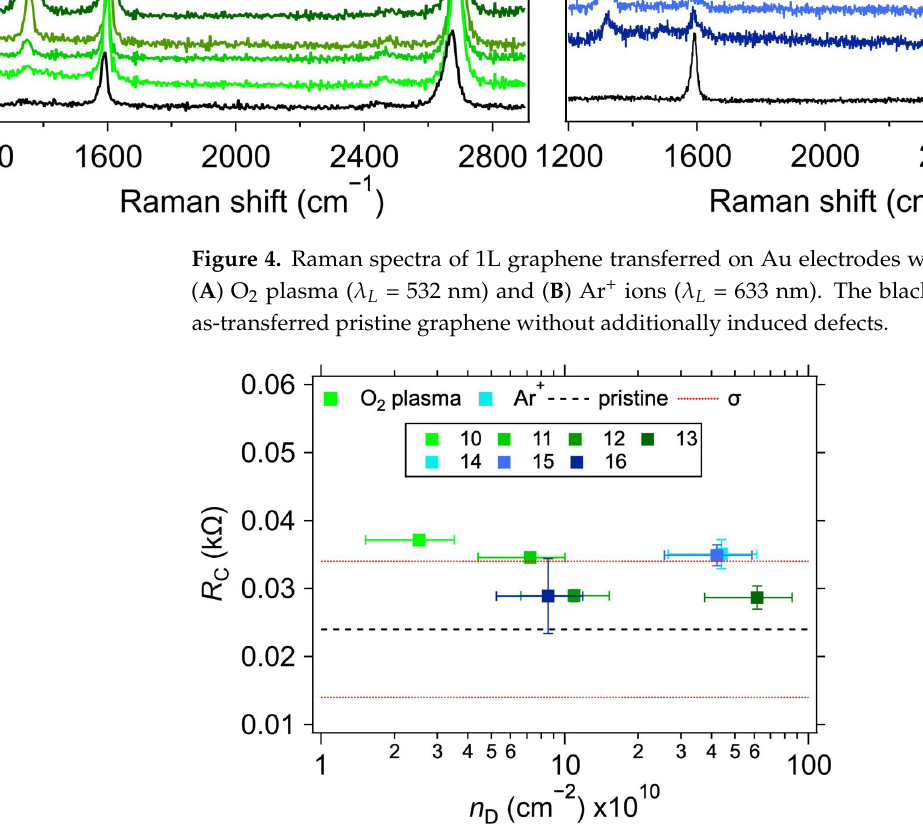
Figure 5. Contact resistance values for 1L graphene on Au electrodes as a function of defect concentration ( n D ). The black dashed and beige solid horizontal lines represent the average and one standard deviation ( σ ) of R C values for the as-transferred 1L graphene on Au electrodes without added defects. The error bars reflect the uncertainties in n D calculation from Equation (3) and one standard deviation of the linear fits for the R C determination.